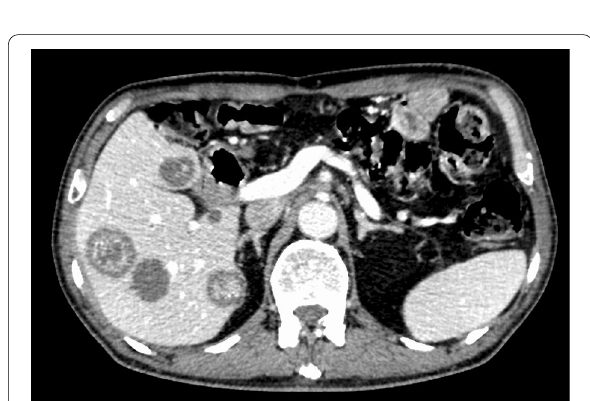
Fig. 3 Contrast-enhanced CT. Multiple low-density areas in the liver were revealed. Cystoid nodes and irregular tumors with internal high density were